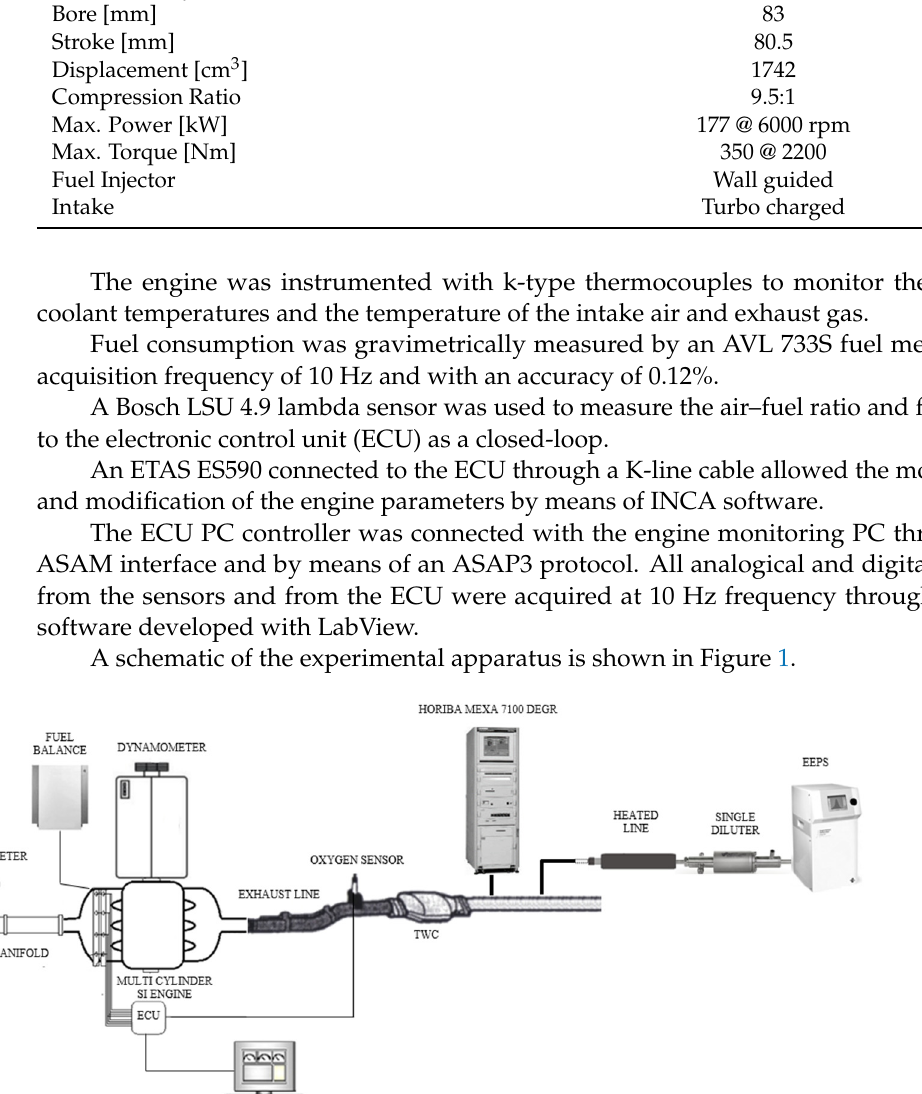
Table 1. Engine specifications.